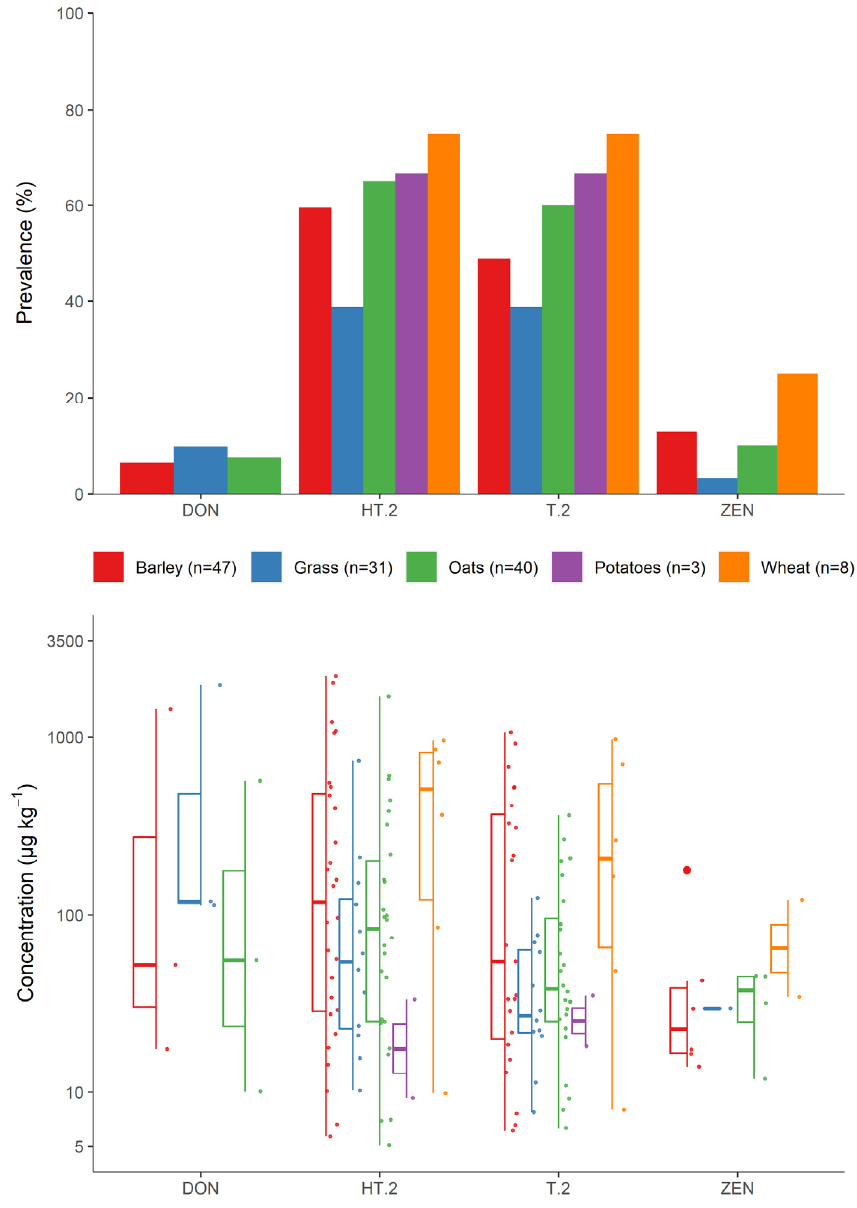
Figure 5. Prevalence of each mycotoxin ( top ) and the distribution of detected levels ( bottom ), by type of previous crop.